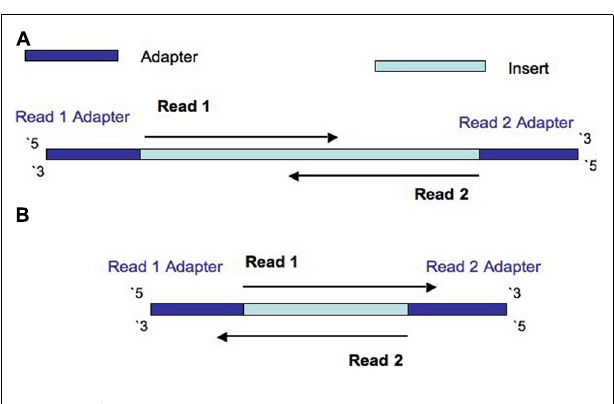
FIGURE 2 | Diagram to show the construction of a fragment with an insert size is less than the length of both reads, but more than the length of a single read (A), and the construction of a fragment with an insert size is less than the length of a single read